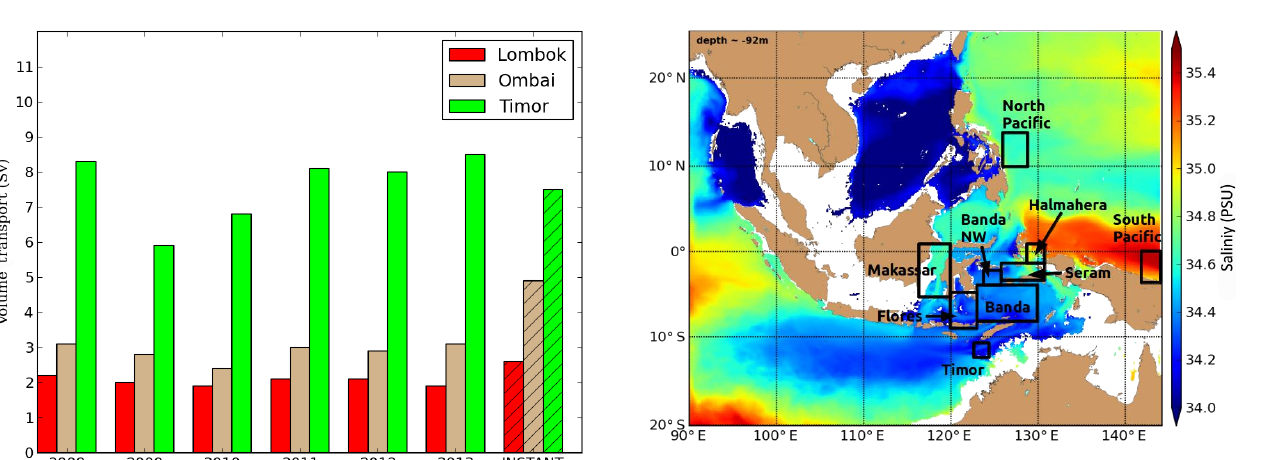
Figure 15. Main areas of water mass transformation. Colour shad- ing indicates salinity at 92m